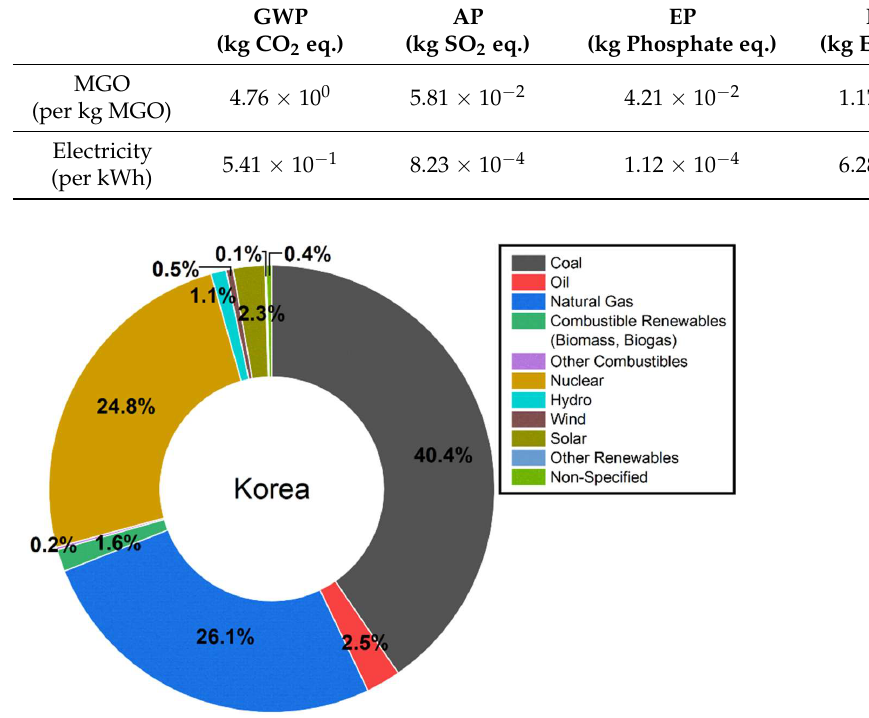
Table 8. Functional units of fuels used in ships made in Korea.